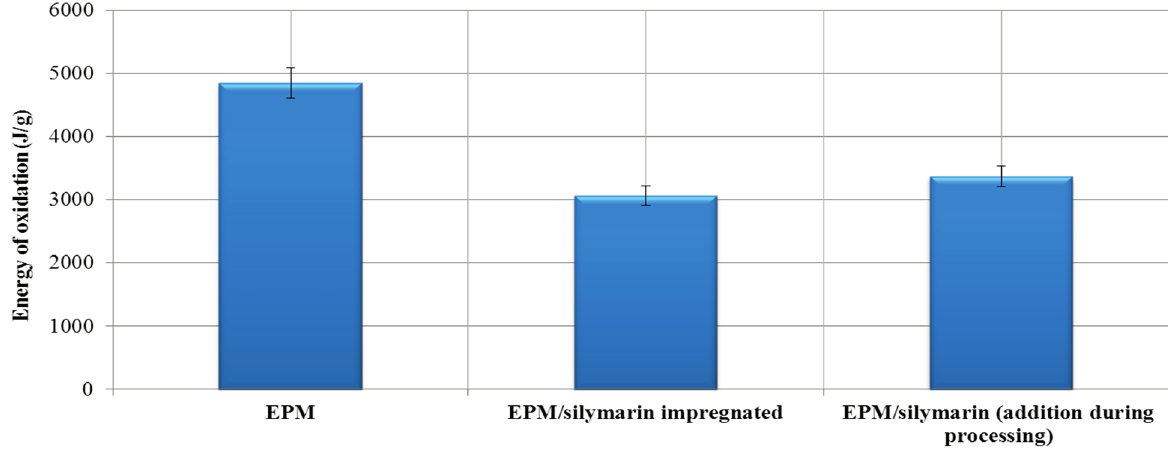
Figure 5. Energy of induction oxidation of EPM composite with